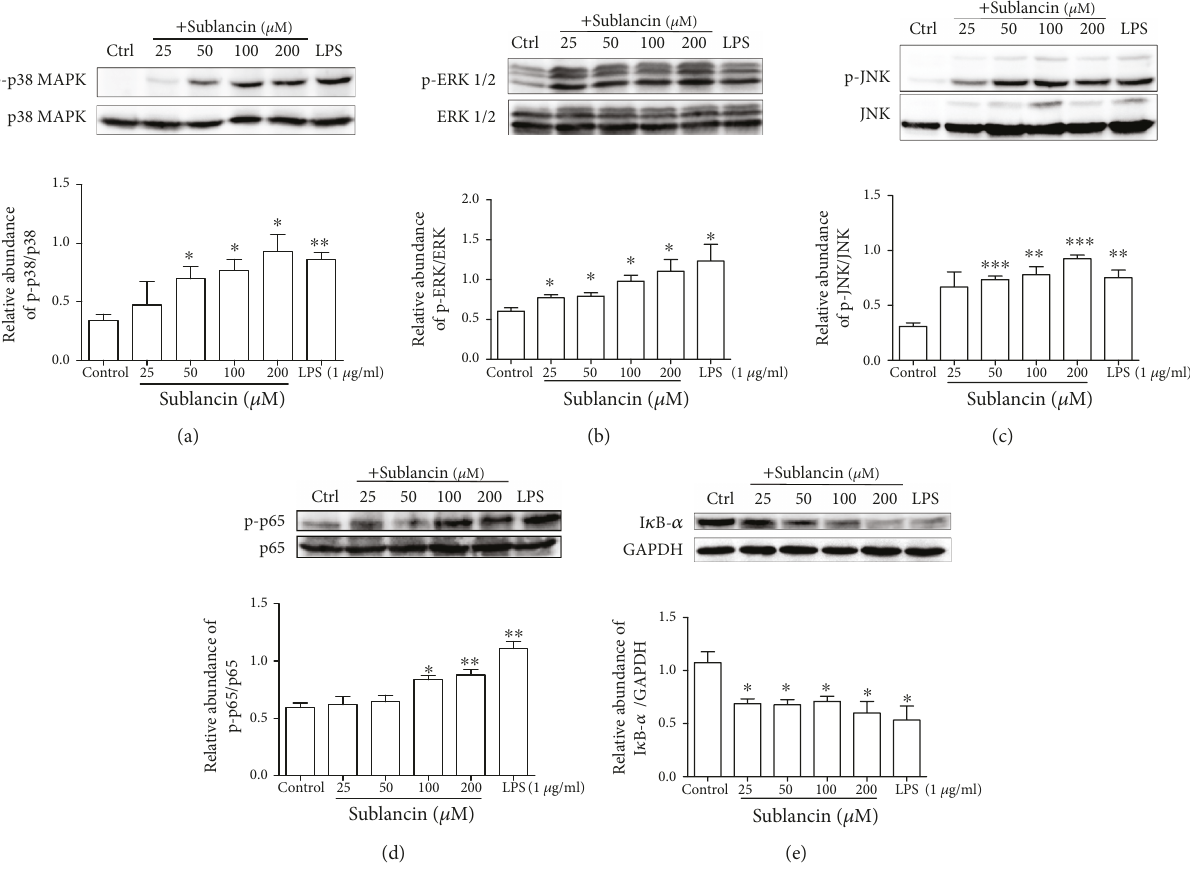
Figure 4: Sublancin regulates the MAPK and NF- κ B signaling pathways in macrophages. Representative Western blots for phosphorylated p38 and total p38 (a), ERK1/2 (b), JNK (c), and p65 (d) in RAW264.7 cells treated with sublancin (0-200 μ M) or LPS (1 μ g/ml) for 30 min. Relative abundance was represented as phosphorylated protein to total protein expression. (e) Western blot analysis and quanti fi cation of I κ B- α in RAW264.7 cells treated with sublancin (0-200 μ M) or LPS (1 μ g/ml) for 30 min. The values are presented as mean ± SEM ( n = 3 ). Signi fi cant di ff erences with control cells were designated as ∗ P < 0 05 , ∗∗ P < 0 01 , or ∗∗∗ P < 0 001